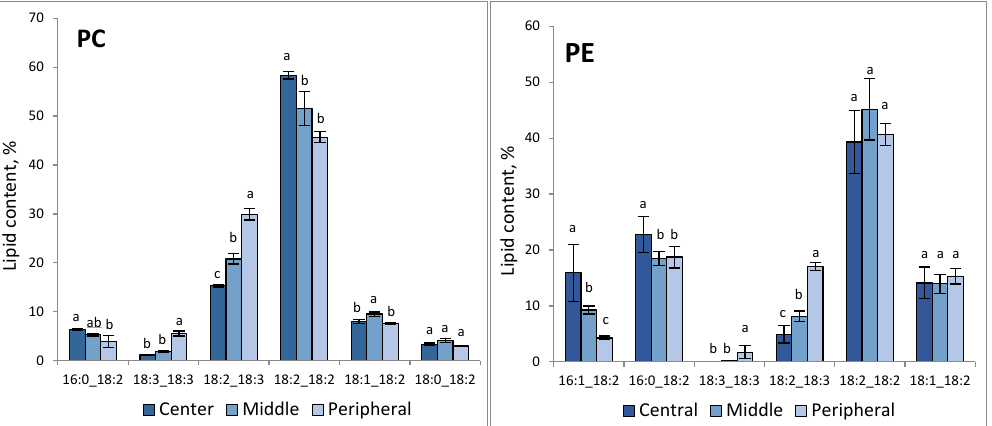
Figure 3. The content of major phospholipid species in different zones of F. velutipes colonies. The experiments were performed in triplicate, and error bars indicate standard deviations. Different letters above the bars indicate statistically significant differences at p -value < 0.05 ( t -test).